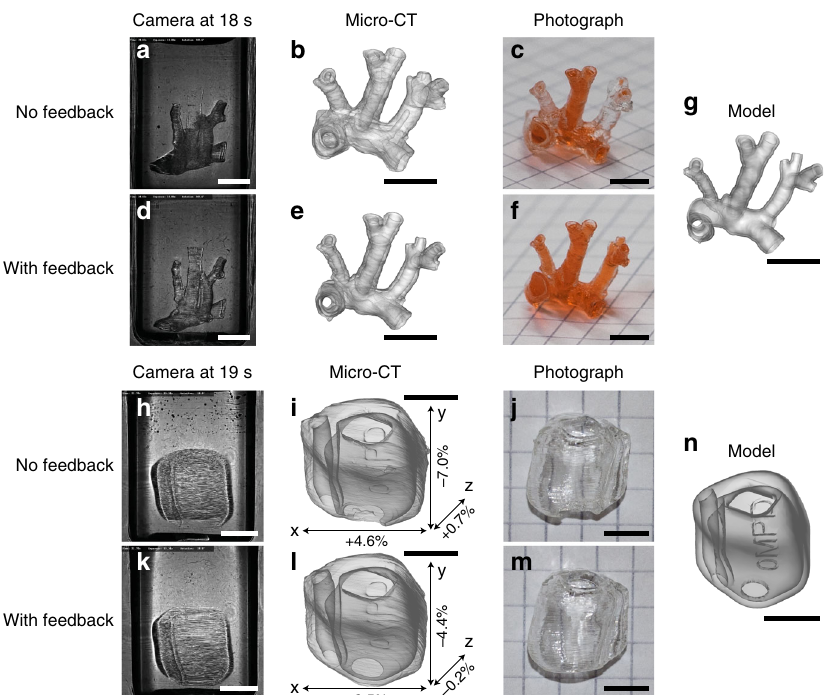
Fig. 4 Improving printing accuracy with an integrated feedback system. a Video snapshot during the printing of the artery without feedback. b Micro-CT scan of the printed artery (without feedback), rendered with transparency to show the occlusions. c Photograph of the printed artery (without feedback) perfused with a red dye, to visualize the open channels. d – f Corresponding data for the artery printed with feedback. g Digital model of the printed artery. A comparative video recording of the artery prints is available as Supplementary Movie 4. h Video snapshot, ( i ) micro-CT rendering, and j photograph of the hearing aid model without feedback. k – m Corresponding data for the hearing aid with feedback. n Hearing aid model. i and l show the deviation of the printed parts with respect to the digital model n , as measured by the micro-CT. The scale bars are 5